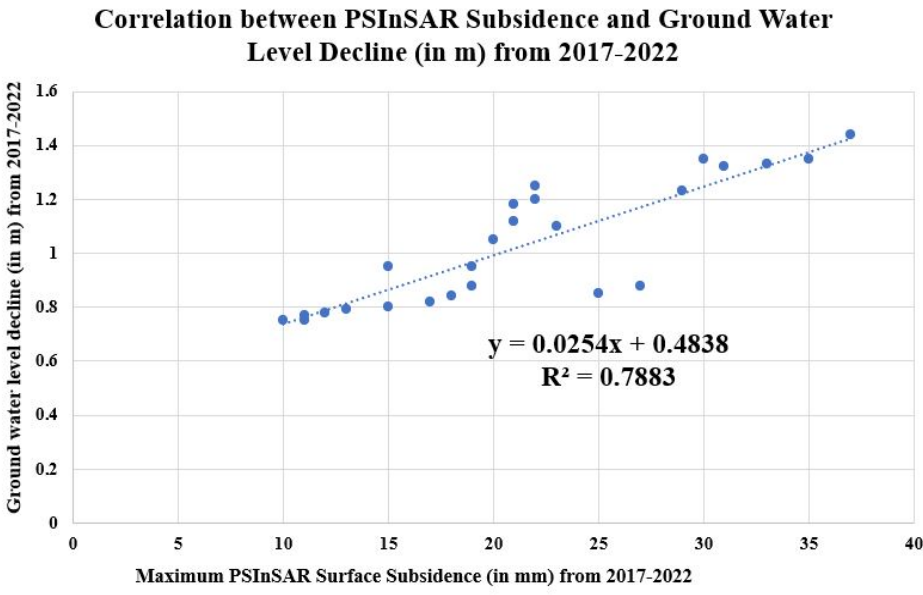
Figure 9. Correlative plot of average PSInSAR-based urban surface subsidence and groundwater data from wells between 2017 and 2022.